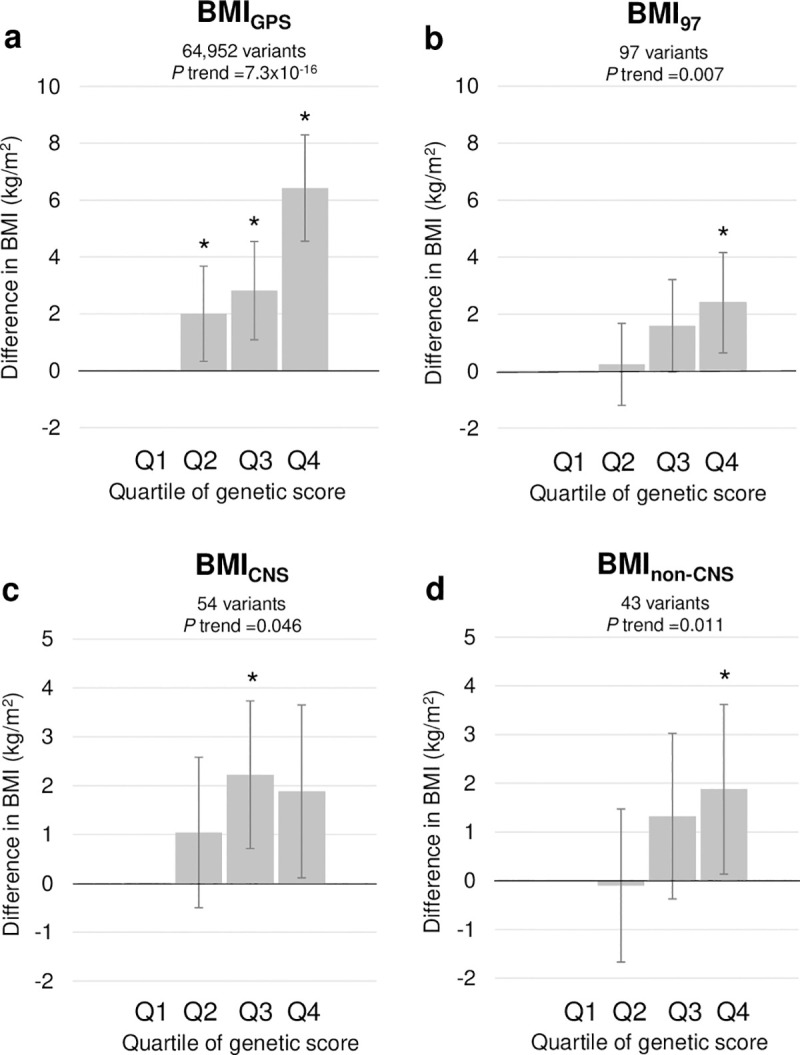
Association of BMI genetic scores with participants’ BMI (in kg/m2) according to quartiles of genetic scores.Higher quartiles reflect more BMI-increasing alleles. y-Axis is difference in BMI (in kg/m2) compared with reference quartile (Q1) adjusted for age, sex, and 5 principal components of ancestry. Asterisks denote significant (i.e., P < 0.05) difference between quartile and Q1. The BMIGPS is a GPS comprising 36,172 BMI-increasing risk alleles across the entire genome. The BMI97 PRS is restricted to 97 previously identified BMI variants at the genome-wide threshold [8]. Based on the biological functions of genes in or near the 97 previously identified BMI loci, the BMICNS PRS and BMInon-CNS PRS comprise 54 variants previously classified as CNS-related and 43 variants previously classified as non-CNS-related, respectively [8]. For interpretation purposes, difference in BMI is derived from models in which BMI is untransformed, whereas P values are derived from models in which BMI is inverse normalized. BMI, body mass index; CNS, central nervous system; GPS, genome-wide polygenic score; OR, odds ratio; PRS, polygenic risk score.